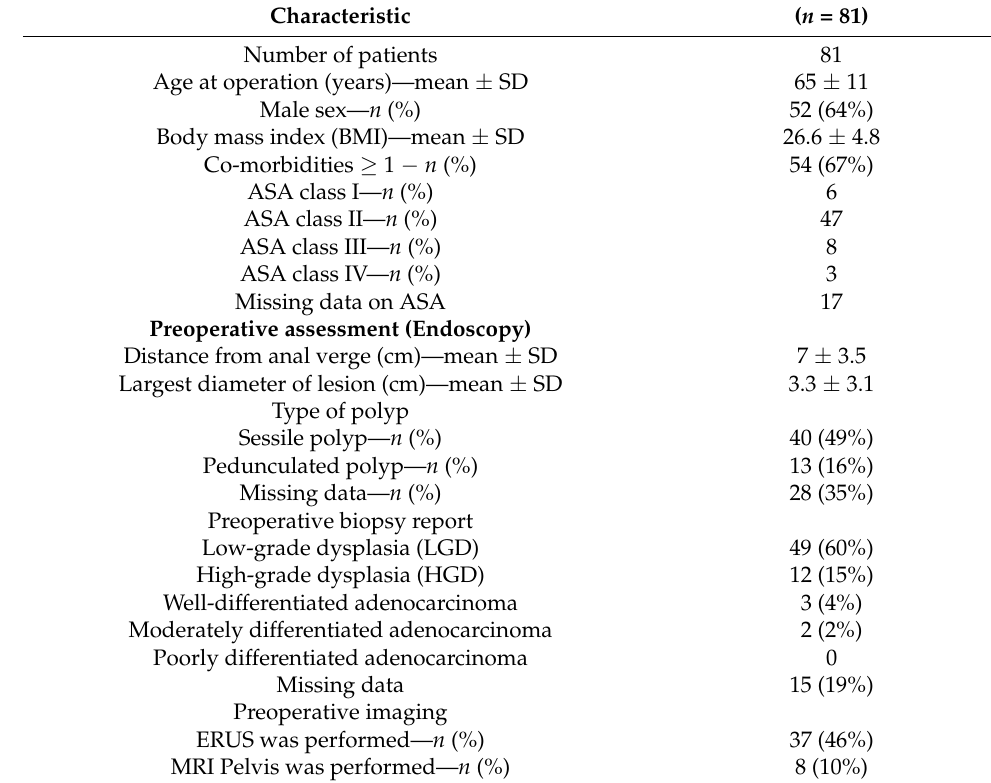
Figure 1. Flow chart of participation in the study, recurrence with rectal cancer. Table 1. Baseline demographic and clinical and imaging characteristics of patients.